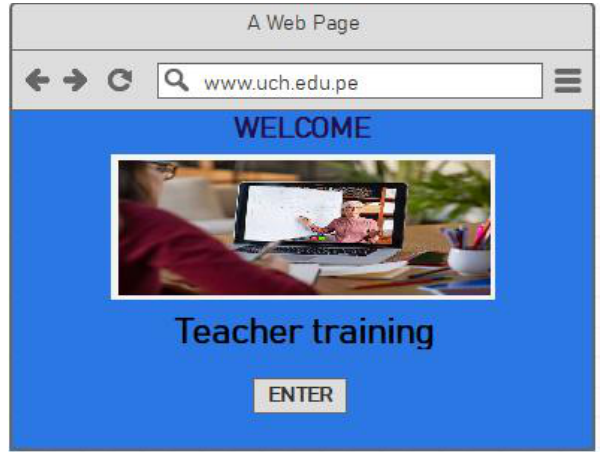
Fig. 6. Web page and its first welcome